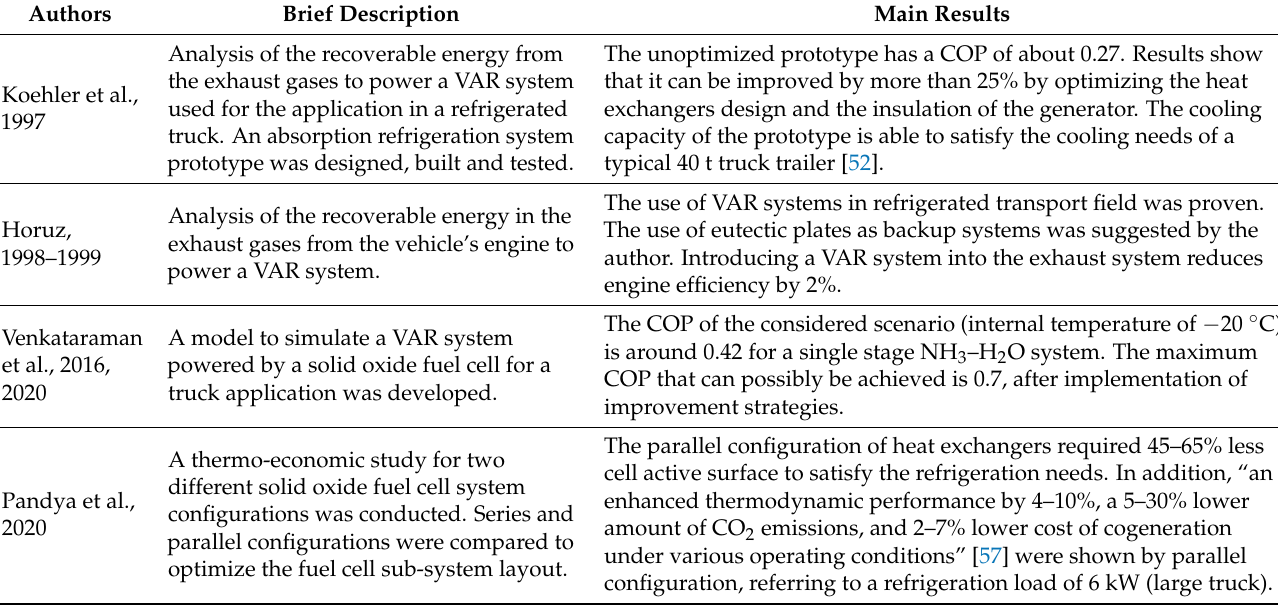
Table 6. Summary of proposed absorption refrigeration systems in refrigerated transport applications.